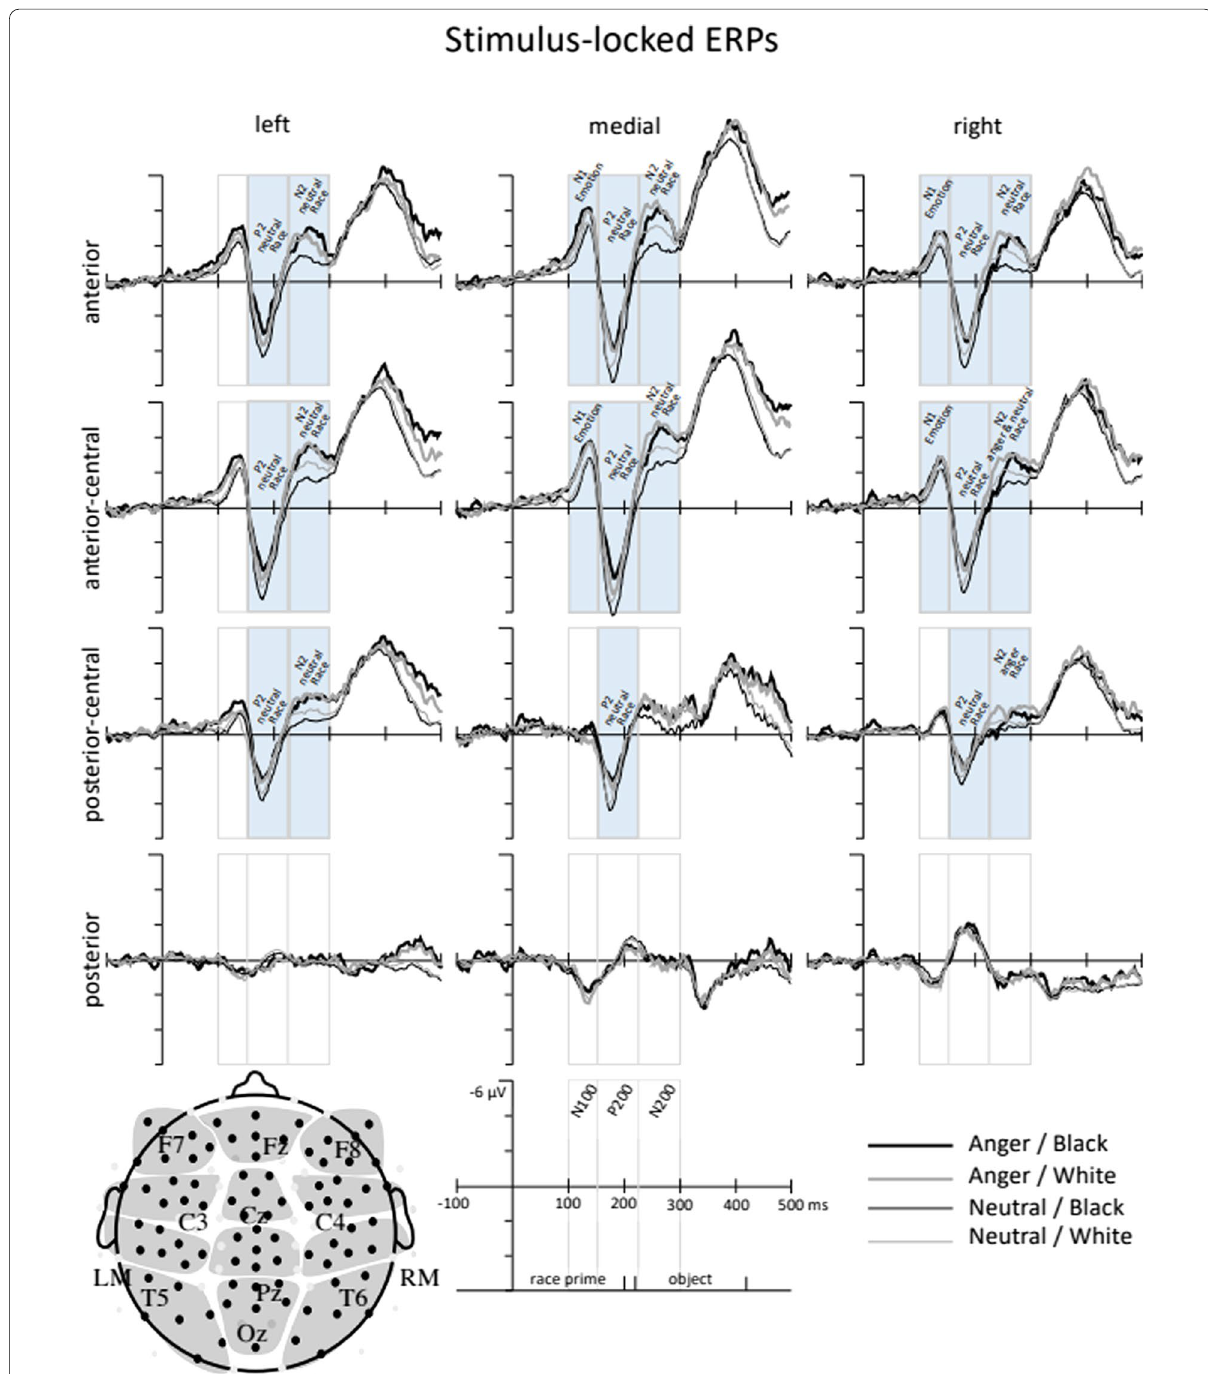
Fig. 4 ERP waveforms time‑locked to the onset of the race prime. The timing of the ERP measurement windows (N1: 100–150 ms, P2: 150–225 ms, and N2: 225–300 ms) and appearance of the race prime (0–200 ms) and object (220–420 ms) are shown on the scale. Emotion condition is distinguished by line thickness (anger thicker, neutral thinner); Race prime is distinguished by line shading (Black = = Faces elicited a larger N1 in the anger condition than in the neutral condition. In the neutral emotion condition only, Black faces elicited a larger P2 than White faces over anterior and anterior‑central regions. In the neutral condition, White faces elicited a larger N2 than Black faces over medial and right anterior regions. Effect significance over each scalp region is indicated with a filled